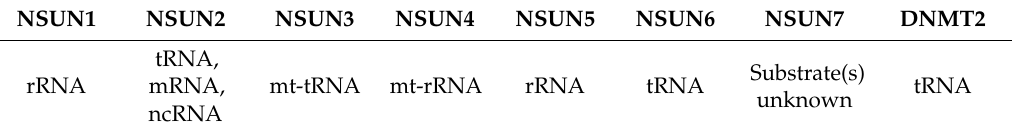
Table 1. The substrates for NOP2 / SUN RNA methyltransferase (NSUN) family